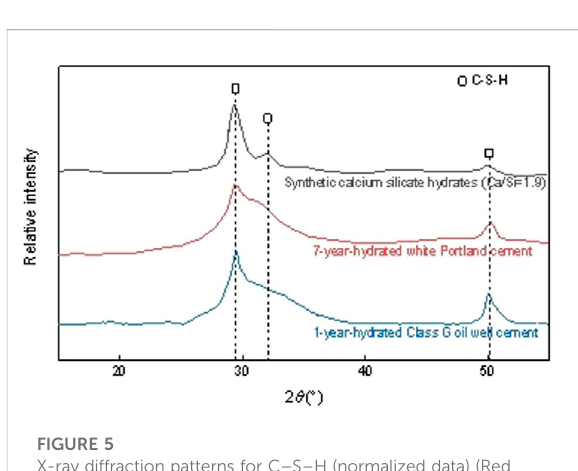
FIGURE 5 X-ray diffraction patterns for C – S – H (normalized data) (Red curve: ref. Snellings et al., 2014b; Black curve: ref. Harris et al., 2022).